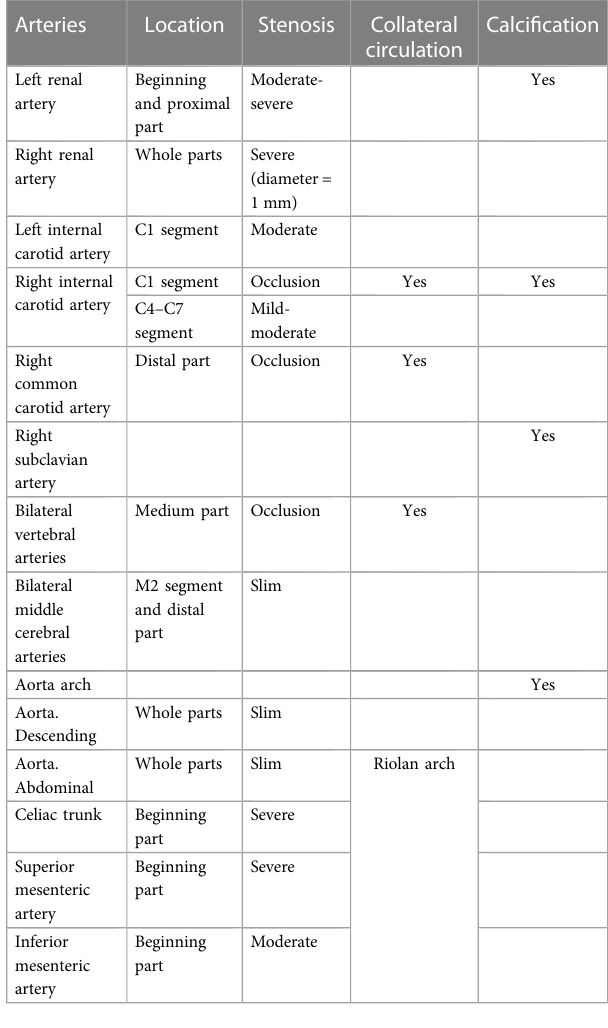
TABLE 2 Stenotic arteries and calci fi cation conditions in the patient. Arteries